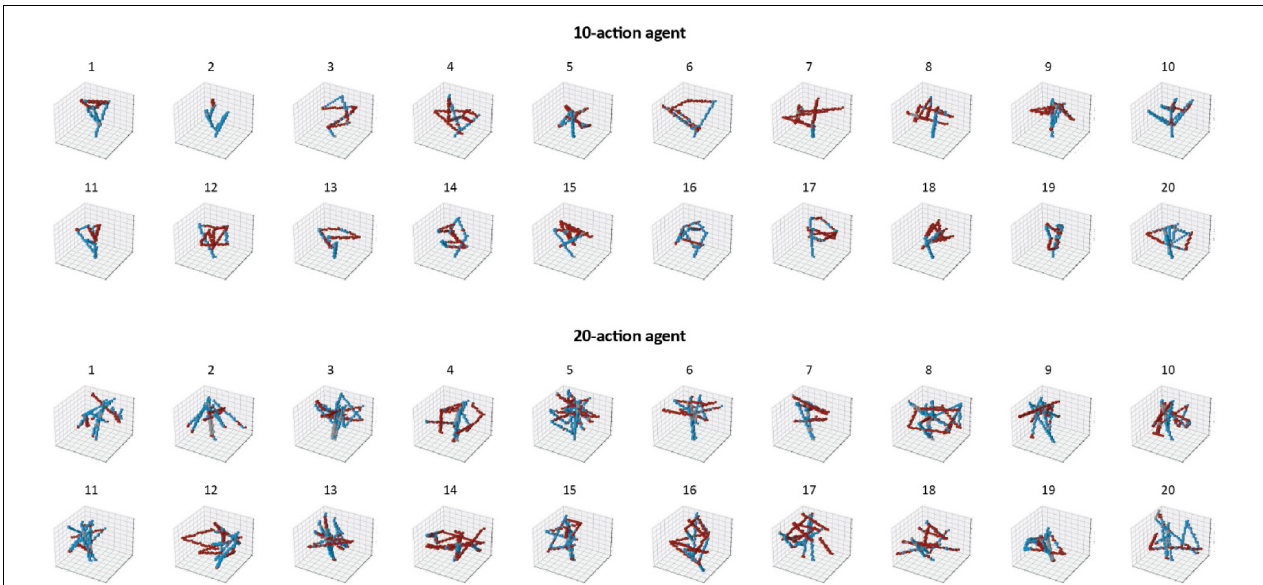
FIGURE 8 | Segmentation of the visual abstraction produced by the 10-action agent and the 20-action agent during the last training